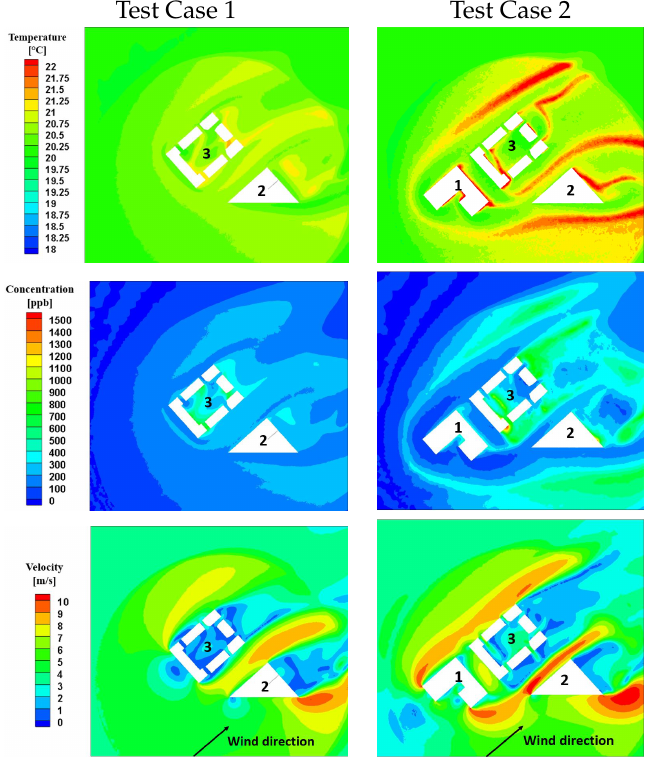
Figure 6. Comparison of temperature, velocity and pollution contours for Test Cases 1 and 2 at the pedestrian level (2 m), bottom heating: 10 ◦ C, cooling intensity: 250 W · m − 3 and wind speed at the inlet: 8